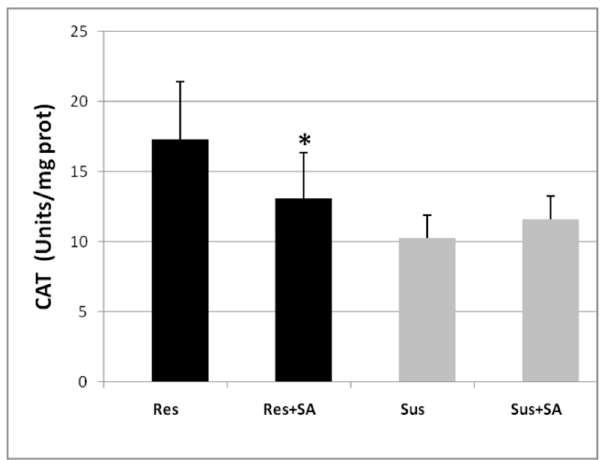
Figure 4. CAT in root extracts of tomato plants from near-isogenic lines resistant (Res, cv. Motelle) and susceptible (Sus, cv. Moneymaker) untreated or treated with SA (20 mg/plant); data were taken at 5 dpt. Values are expressed as means ( n =9) ± SD. An asterisk indicates significant difference with respect to controls (Res, Sus), according to a paired t -test ( p < 0.05).